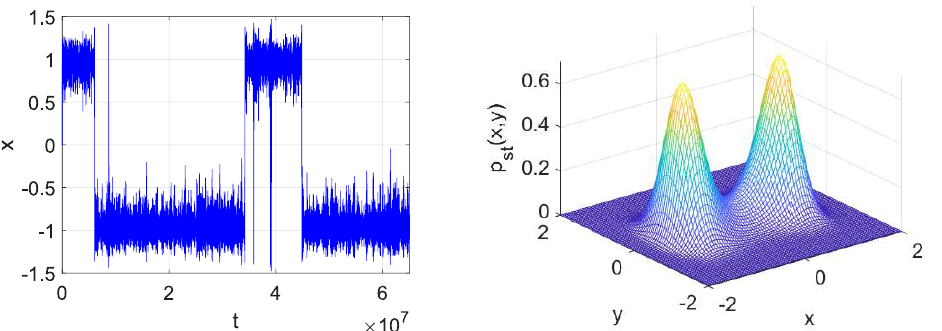
Figure 11. ( Left ) Time behaviour for the mechanical position of a bi-stable piezoelectric energy harvester for small noise intensity. ( Right ) Marginal probability stationary distribution for the mechanical variables for small noise intensity.